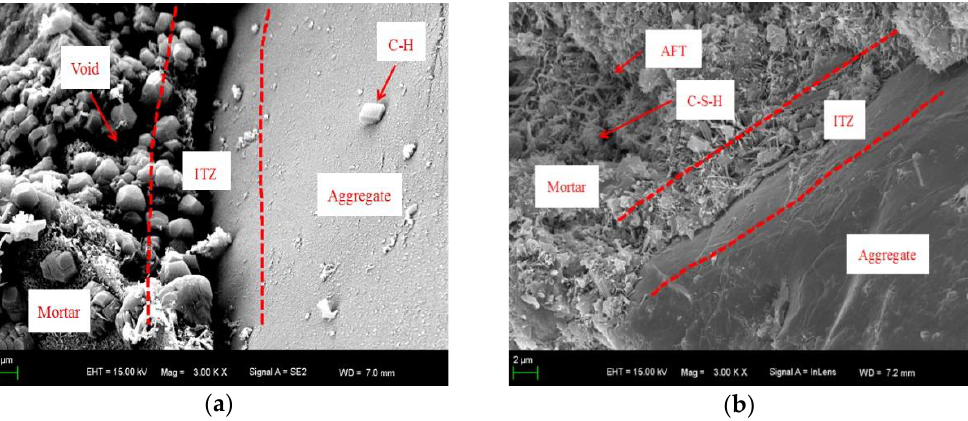
Figure 22. Micromorphology of ITZ of aggregate and matrix. ( a ) SF0 and ( b ) SF10.